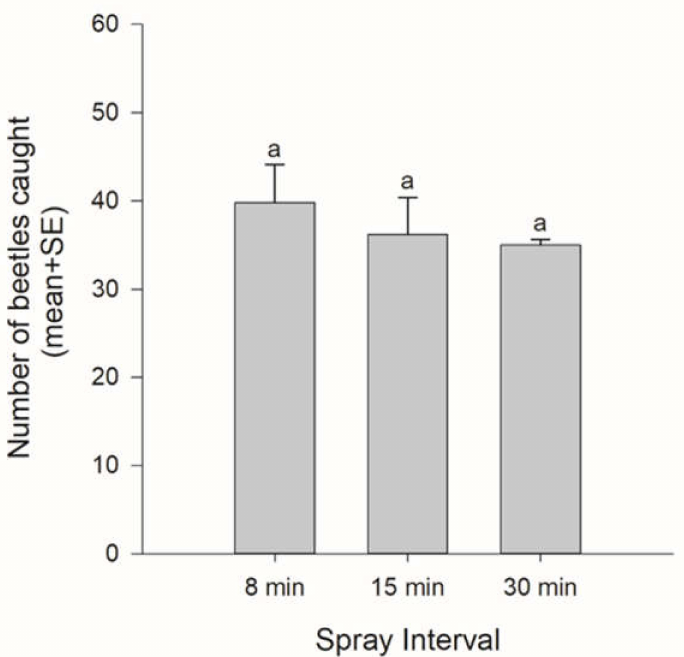
Figure 2. The numbers of beetles caught according to spray intervals (a proxy for the concentration of PA). Bars with the same letters were not significantly different (Tukey–Kramer HSD test, p >